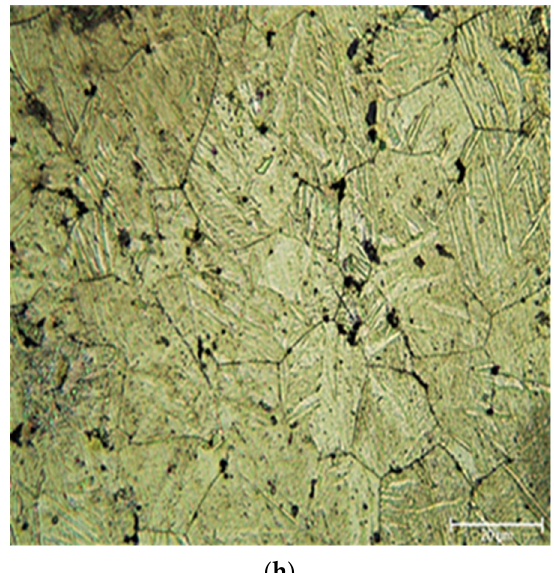
Figure 2. Light microscopy images samples before and after extrusion respectively; ( a , b ) ZK60 alloy, ( c , d ) 15% SiC reinforcement, ( e , f ) 15% SiC + 0.2 AIN reinforcement, and ( g , h ) 15% SiC + 0.5 AIN reinforcement.